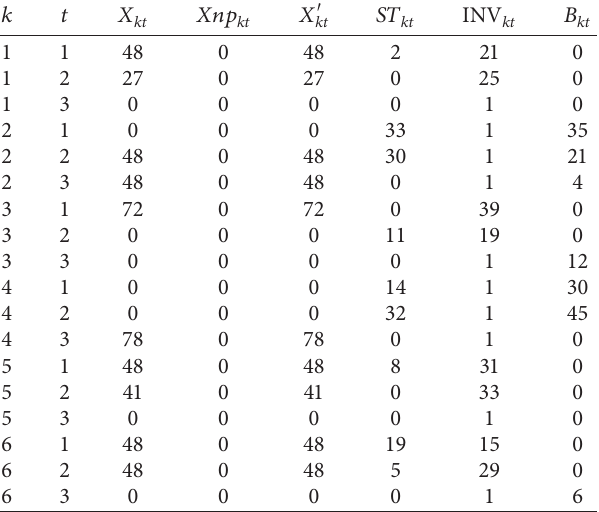
Table 6: Small dataset results of the base LSSP MILP: lot-sizing, inventories, coverage stockout, and backorders.